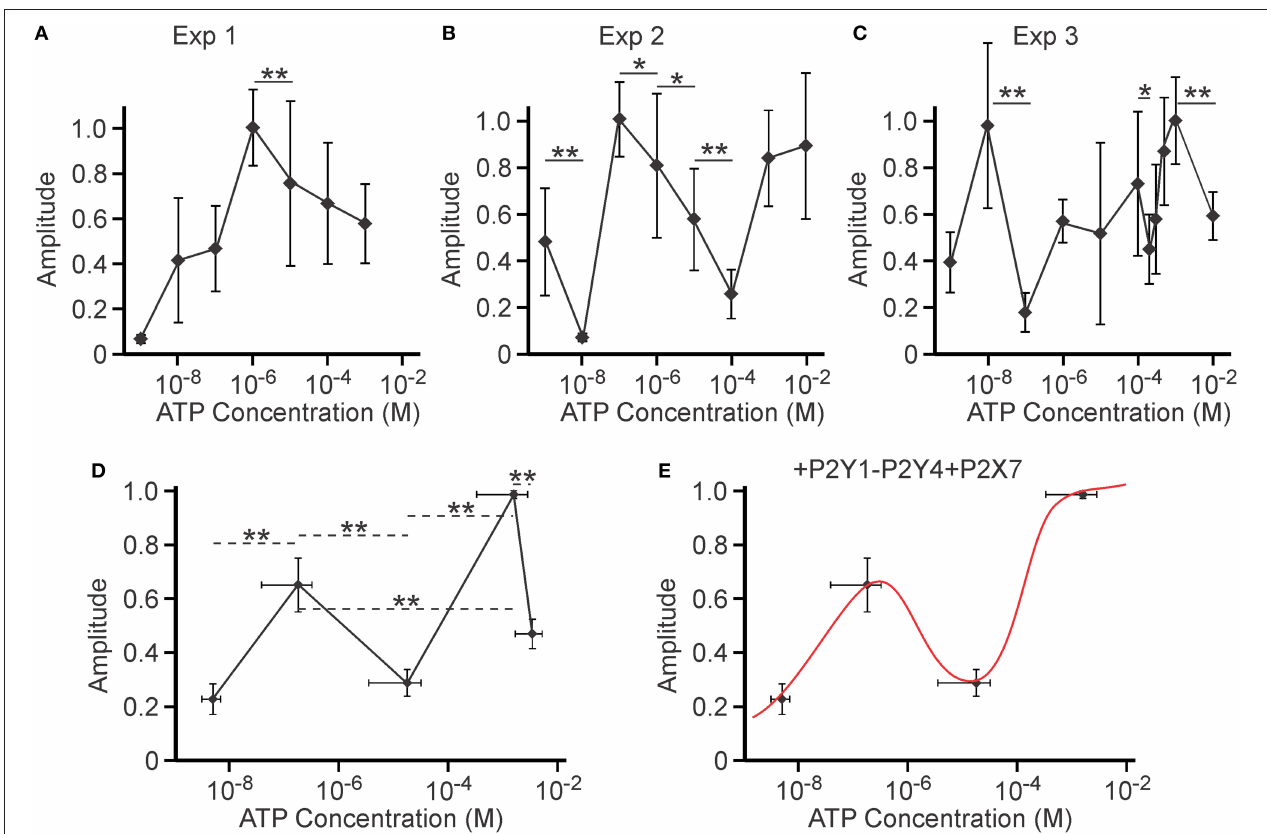
FIGURE 6 | Potential inhibitory role of a P2 receptor activated at intermediate [ATP]. Amplitudes of Ca 2 + responses induced by bath application of 10 − 9 –10 − 2 M ATP to MC3T3-E1 cells loaded with fluo-4 were analyzed. (A–C) The examples of [ATP] dependencies of the peak amplitude of calcium response observed in three independent experiments. Data are means ± SEM, normalized to the maximal response (maximal response = 1) within an experiment, n = 19 –25 cells/concentration for (A) , 11–27 cells/concentration for (B) , 17–31 cells/concentration for (C) . Differences (indicated by horizontal lines) were analyzed by ANOVA and were significant for all cases, with p < 0.0001 . Selected statistically significant differences are shown with asterisks that demonstrate significant decreases in amplitude with an increase in applied [ATP] assessed by Tukey post-test (* p < 0.05 , ** p < 0.01 ). (D) Eight experiments were analyzed for ATP concentrations and relative amplitudes of (i) the initial low response, (ii) the first peak, (iii) the lowest value between the peaks, (iv) the second peak, and (v) the lowest value after the second peak. Means ± SEM for [ATP] and relative amplitudes were plotted. Differences (indicated by horizontal dashed lines) were analyzed by ANOVA ( p < 0.0001 ), followed by Tukey post-test; ** p < 0.01 . (E) The resulting concentration dependence was fit with the linear combination of P2Y1, P2Y4, and P2X7 functions ( ky1 = 1.8 ± 0.4; ky4 = − 1.4 ± 0.4 ; kx7 = 0.6 ± 0.2, R 2 = 0.99